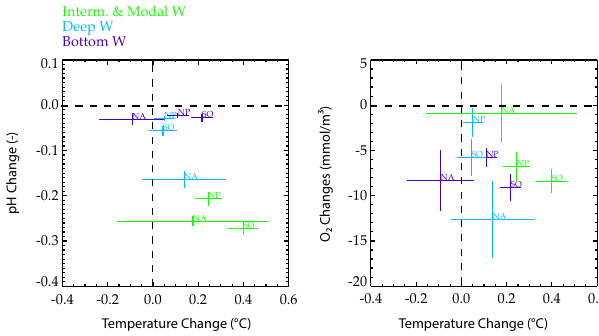
Fig. 12. Relations between model-mean changes in pH (pH unit), dissolved O 2 (mmolm − 3 ) and model-mean temperature change ( ◦ C), in four distinct global water masses (tropical water mass, modal and intermediate water mass, deep water mass and bottom water mass) and for the four different RCPs. For a definition of the different water masses, please see Sect. 2.3. Inter-model standard deviations are also indicated.